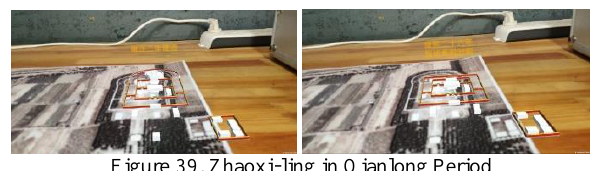
Figure 39. Zhaoxi-ling in Qianlong Period Figure 40. Zhaoxi-ling in Yongzheng Period